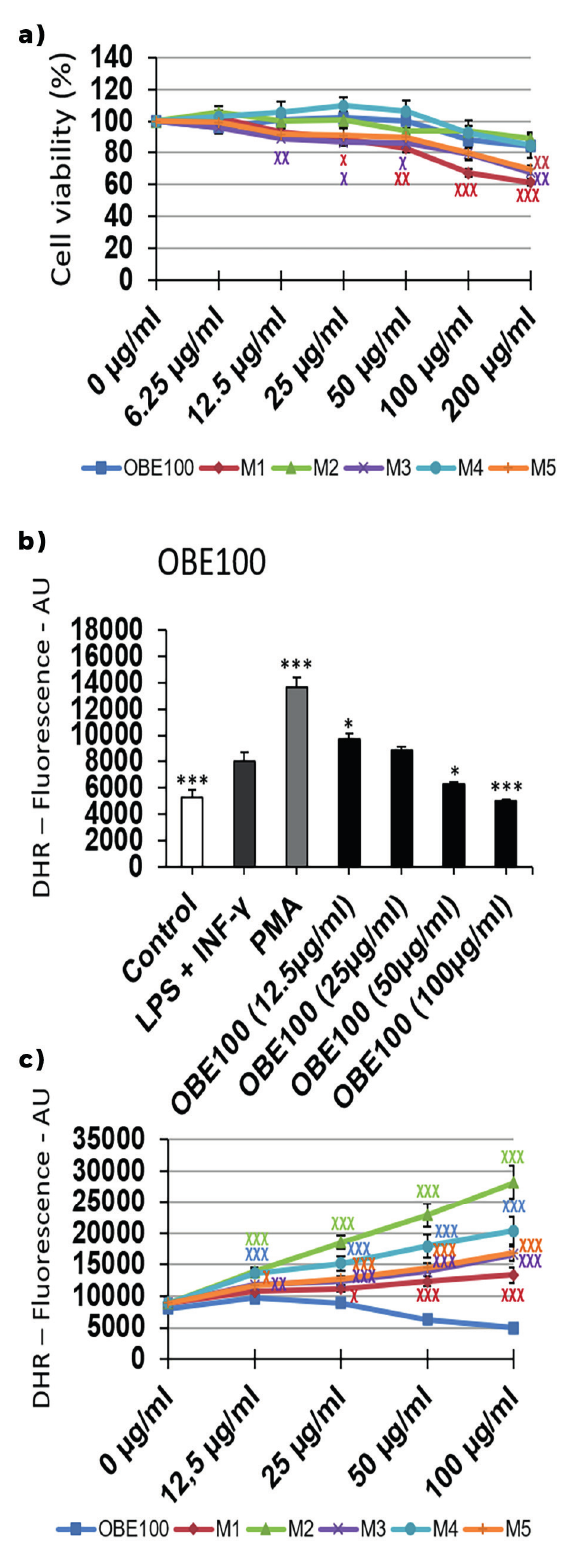
Figure 1. Effect of triterpenoid mixtures on cell viability and oxidative burst in activated